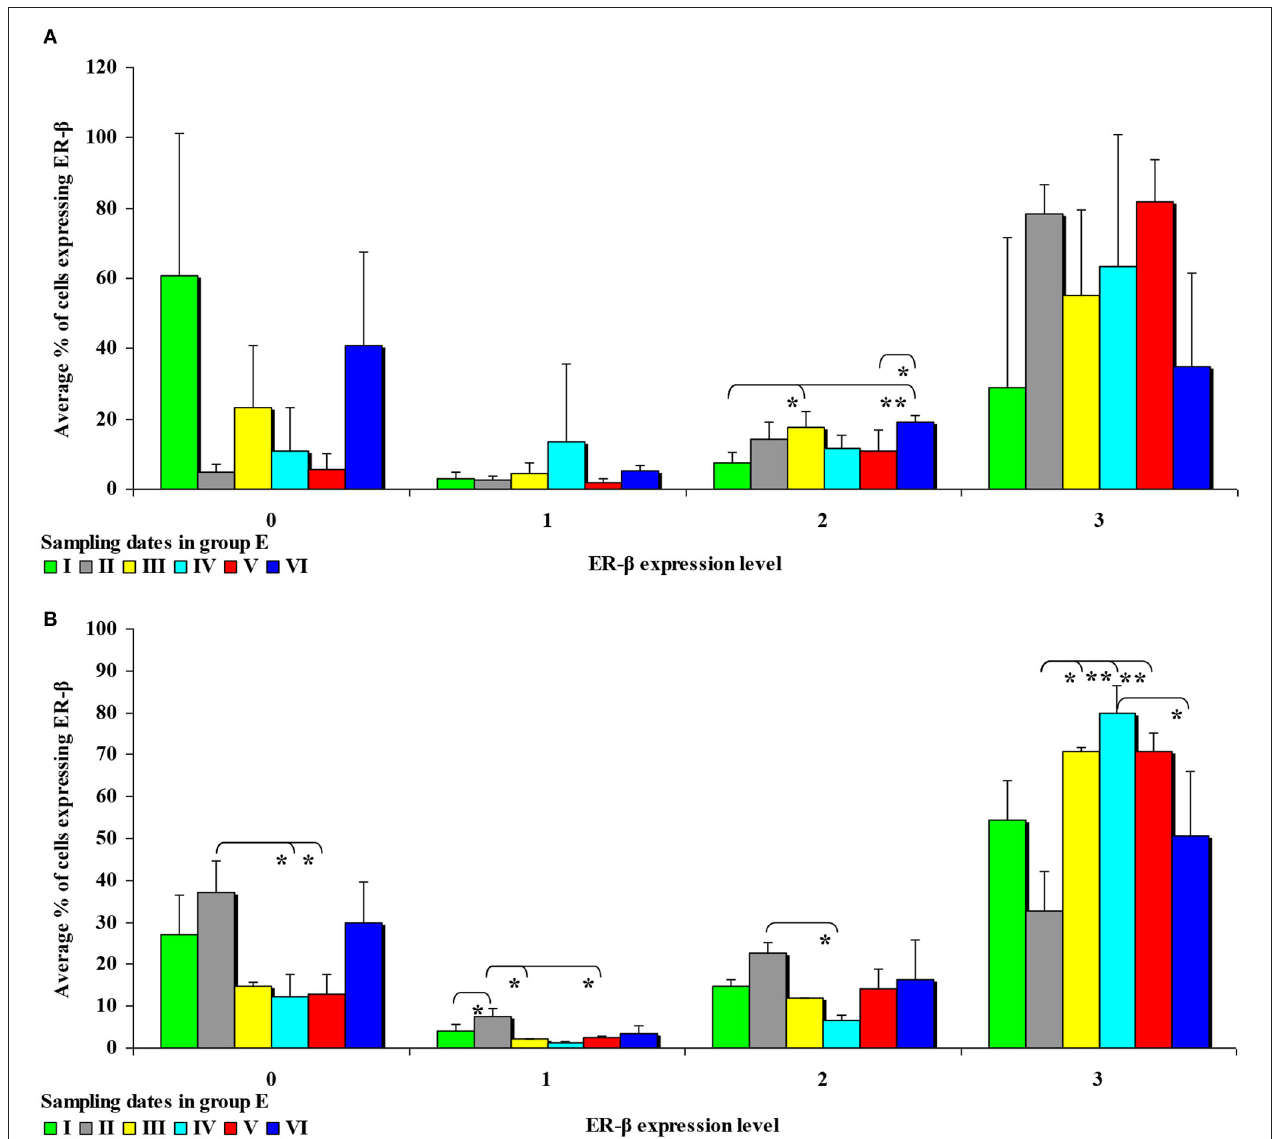
FIGURE 8 | The effect of DON on the immunohistochemical expression of ER β (graded on a 4-point scale: negative = 0 points; weak and homogeneous = 1 point; mild or moderate and homogeneous = 2 points; intense or strong and homogeneous = 3 points) in the intestines of pre-pubertal gilts from group E: (A) in the duodenal cap in selected weeks of exposure; (B) in the ascending colon in selected weeks of exposure. ER β expression is presented as mean values ( ± ) and standard deviation (SD) in selected samples. * P ≤ 0.05 and ** P ≤ 0.01 compared with the remaining